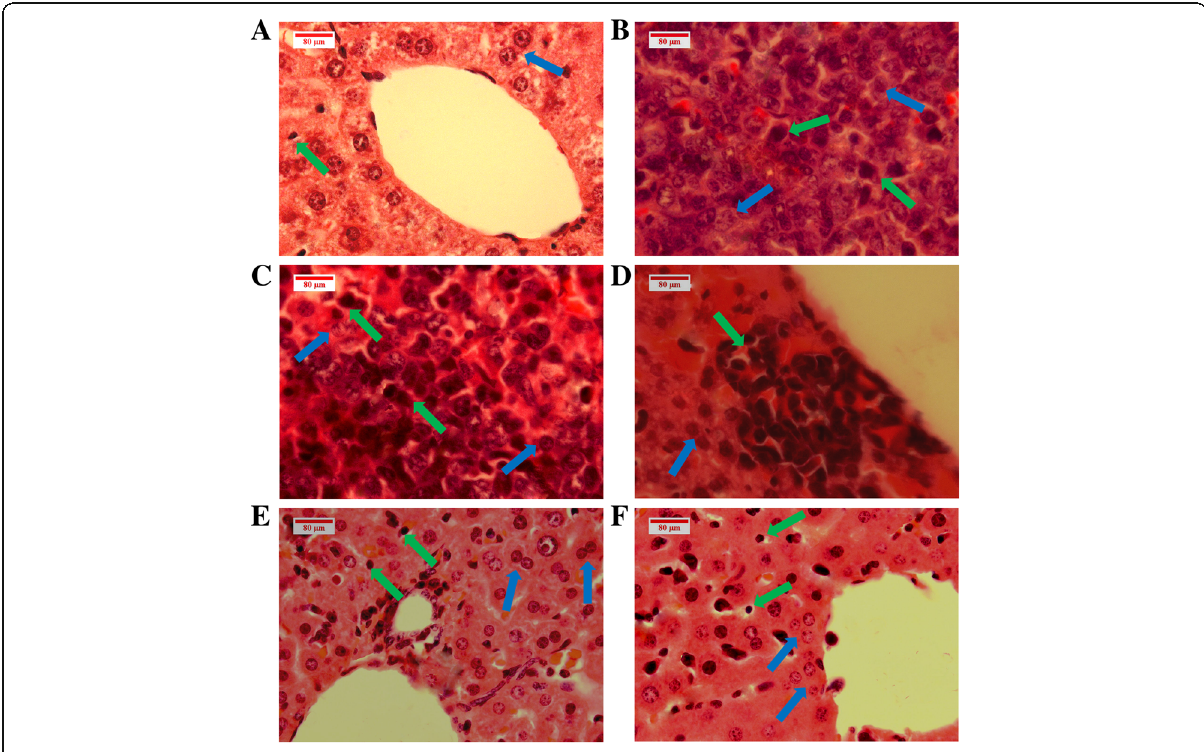
Fig. 13 Histopathology of the liver tissues. The image shows ( a ) normal hepatocytes ( blue arrow ). b , c BALB/c mice injected with WEHI-3 cells. The leukaemia sectioning shows that the hepatocyte cells were damaged ( blue arrows ), and the kupffer cells are larger ( green arrows ). d , e BALB/c mice injected with WEHI-3 cells and treated with 30 and 60 mg/kg of BM. f Treated by vinblastine: the sections show improvement in the liver histology, compared to the leukaemia